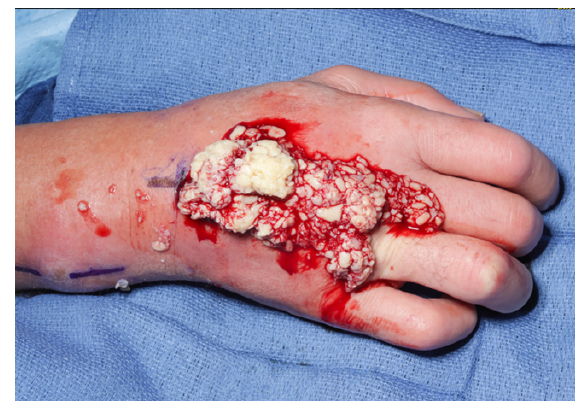
Figure 9. Intraoperative appearance of the right wrist demonstrat- ing extensive purulent material evacuated from the dorsum of the hand.